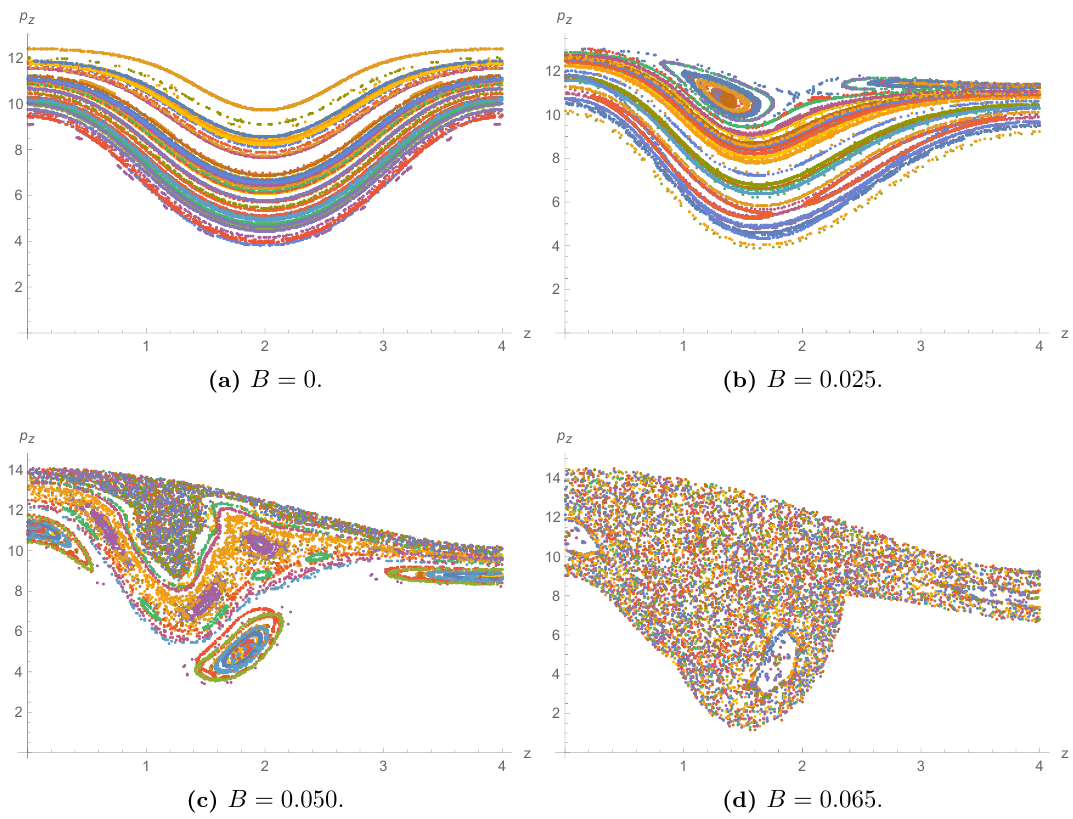
Figure 8. Poincar(cid:19)e sections for ( z; p z )-plane at (cid:31) ( t ) = 0, for high energy string con(cid:12)gurations ( E = 45) on backgrounds with values of B . As we increase B , we clearly see the onset of chaos as more and more KAM tori break apart until there is no structure left and we have a purely chaotic